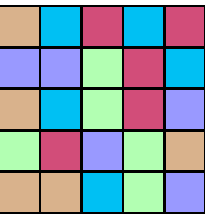
FIG. 9. A perfect classical strategy for the d = 5 Torpedo Game. As Fig. 8, the same colored cells belong to the same par- tition. The lines that avoid Alice are depicted below for every question Bob can be